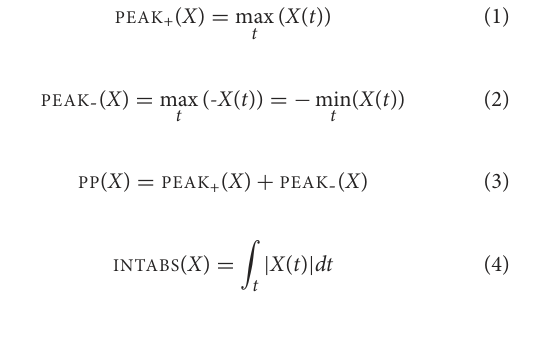
and thread entry times automatically determined by